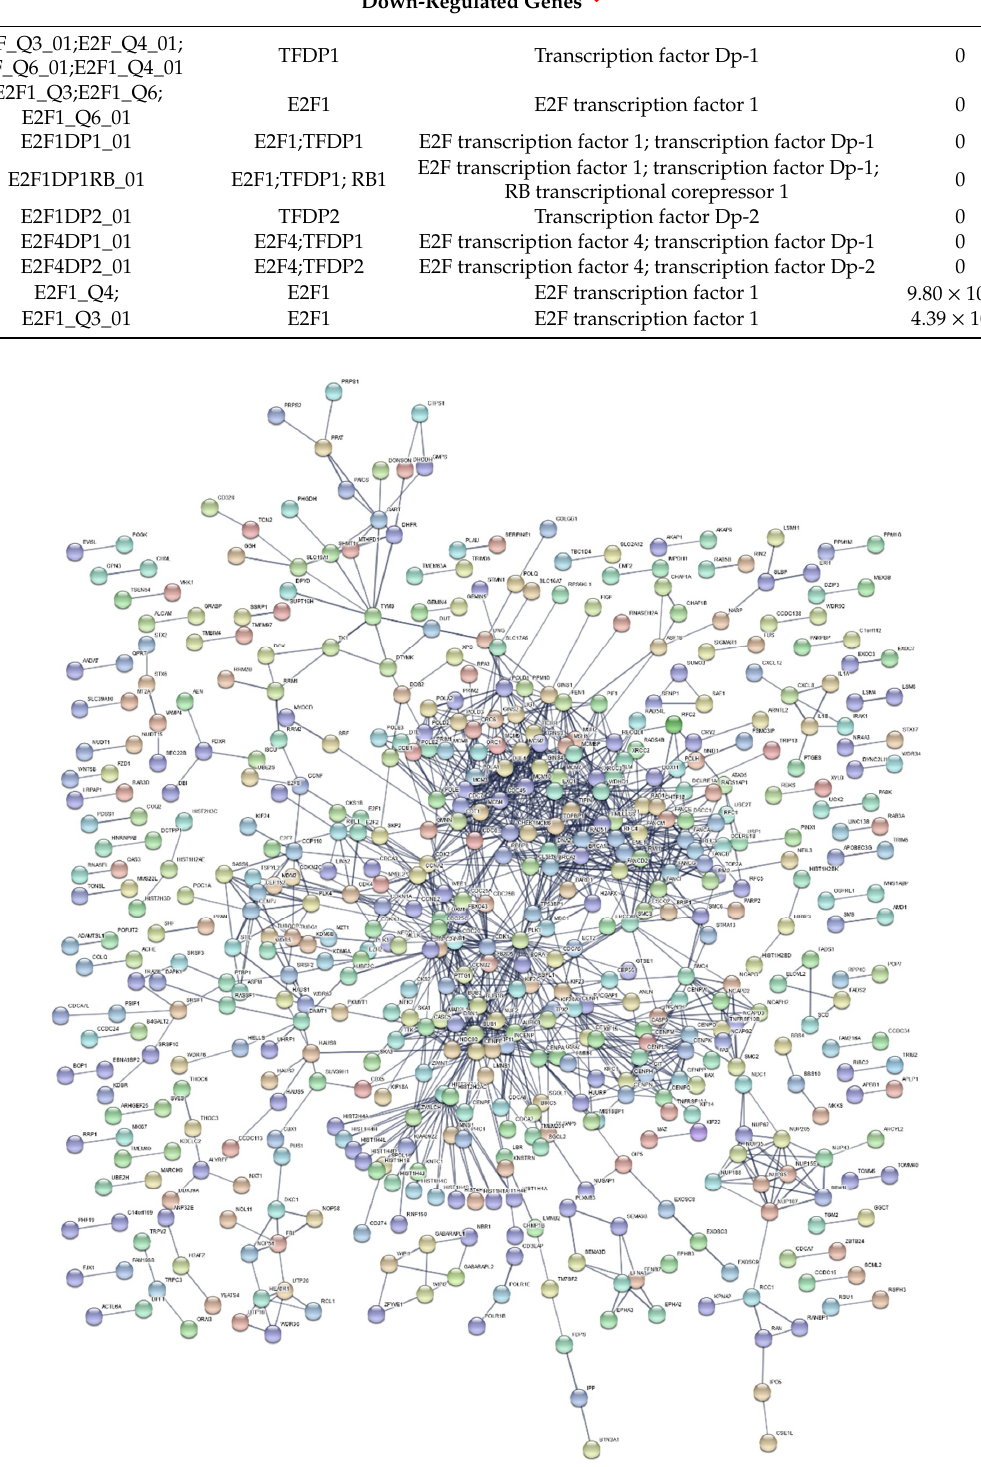
Table 4. Enriched gene-targeting transcription factors for down-regulated genes after meta-analysis. Gene Set